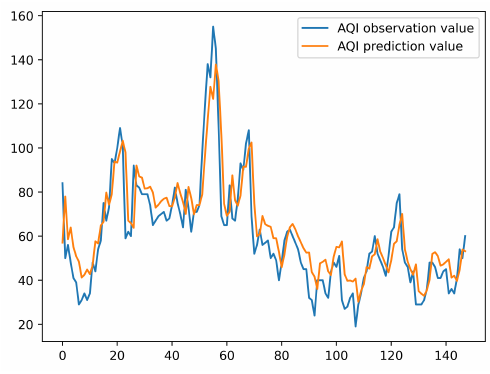
Figure 4. CNN air quality index prediction